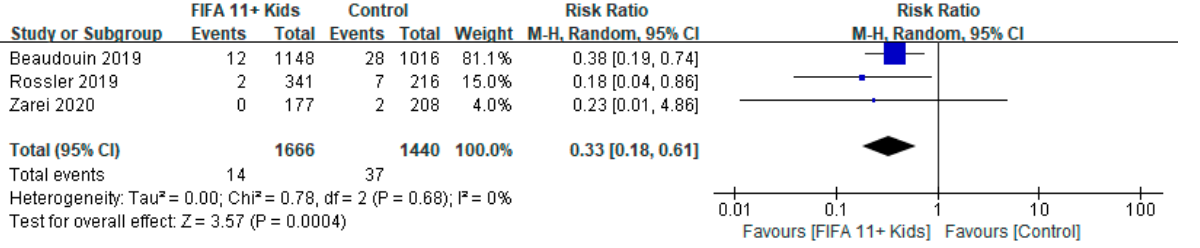
Figure 3. Secondary analysis of severe injury rates in the “FIFA 11+ Kids” program compared with control intervention on the number of severe injuries [17,27,28].